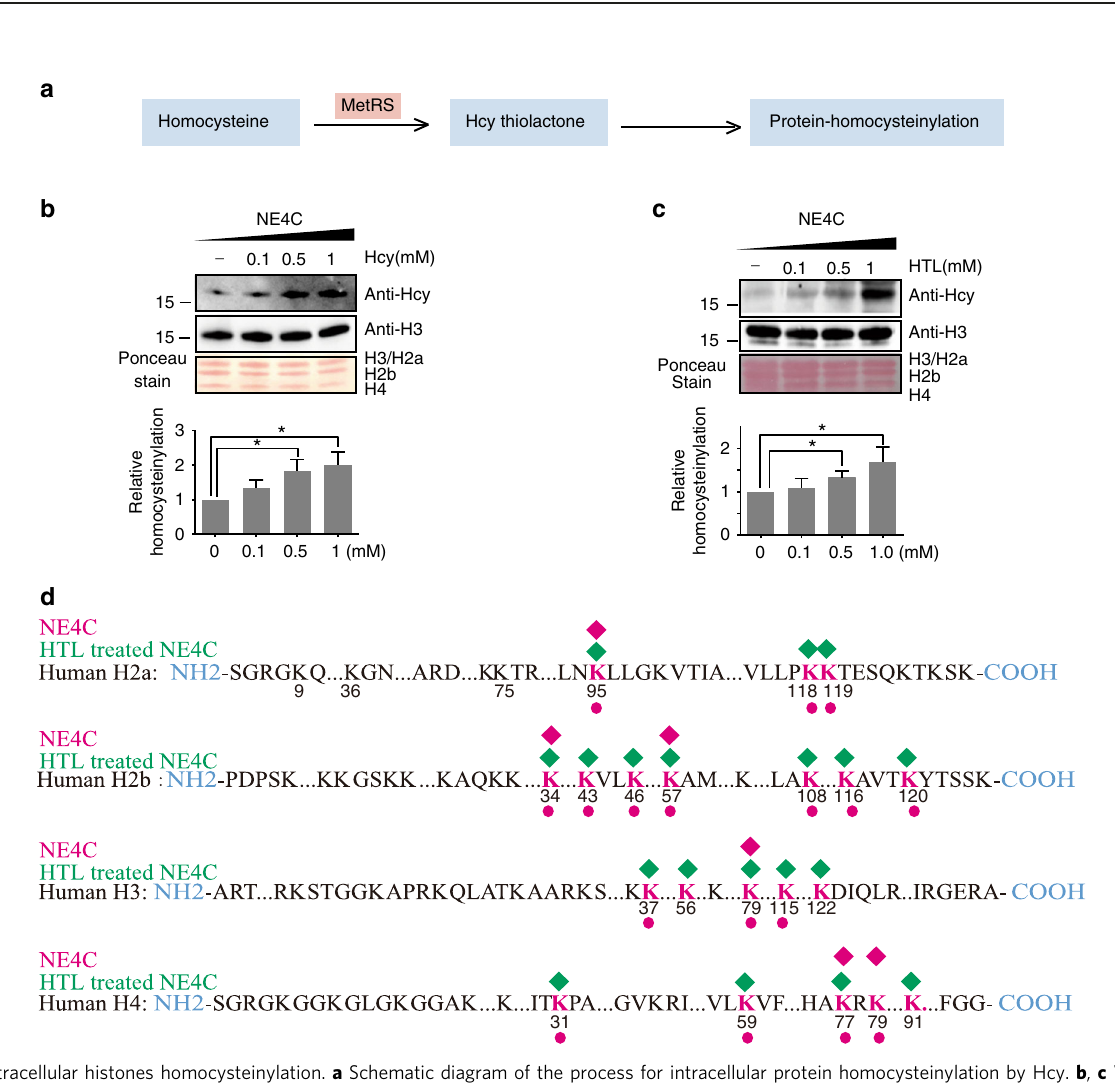
Fig. 2 Direct in vitro histone homocysteinylation by HTL. a Schematic illustration of protein modi fi cation by HTL. b Dot-blot analysis of histone homocysteinylation by HTL. The unmodi fi ed histones H3, H4, H2a, and H2b expressed from E. coli were used. Top panel: four histones were incubated with 5 mM HTL for 2 h and histone homocysteinylation was detected using anti-Hcy antibodies. ( + : positive control, tubulin antibody diluted 1:1000 was used as the positive control; – : negative control, sodium phosphate buffer was used as the negative control); Middle panel: histone H3 was treated with 5 mM HTL for 2, 6, and 14 h, respectively, and histone homocysteinylation was detected using anti-Hcy antibodies. Bottom panel: histone H3 was treated with 0.5 mM, 1 mM, 5 mM, and 10 mM HTL respectively for 2 h and histone homocysteinylation was detected using anti-Hcy antibodies. c MALDI analysis of unmodi fi ed H3 from E. coli with (bottom) or without (top) in vitro HTL treatment. The undigested H3 display a major peak of about 15KD. Additional major peaks greater than 15KD are seen in HTL-treated H3 samples. The difference in molecular mass between the adjacent two peaks is in the proximity of 3 Hcy modi fi cations, indicating that multiple, simultaneous KHcy modi fi cations may exist on H3 during HTL treatment. The x and y axes represent m / z and relative ion intensity, respectively. d A typical HPLC-MS/MS spectra of a tryptic peptide ‘ GVLK Hcy VFLENVIR ’ derived from HTL-treated H4 with homocystylation at H4K59 site. The x and y axes represent m / z and relative ion intensity, respectively. A series of b- and y-type homocysteinylation fragment ions are evident which not only provide reliable sequence information, but also indicate an unambiguous + 174.04600 Da shift for Hcy. e Illustration of histone homocysteinylation sites identi fi ed by HPLC-MS/MS analysis on unmodi fi ed core histones treated with HTL. The green diamond shape depicts homocysteinylation sites in core histones (H3, H4, H2a, and H2b). The number underneath each red lysine residue (K) represents the position of the particular lysine residue within each respective histone. Homocysteinylation sites, present both naturally in normal human brain samples (Fig. 1b) and after in vitro HTL treatment are marked with a red